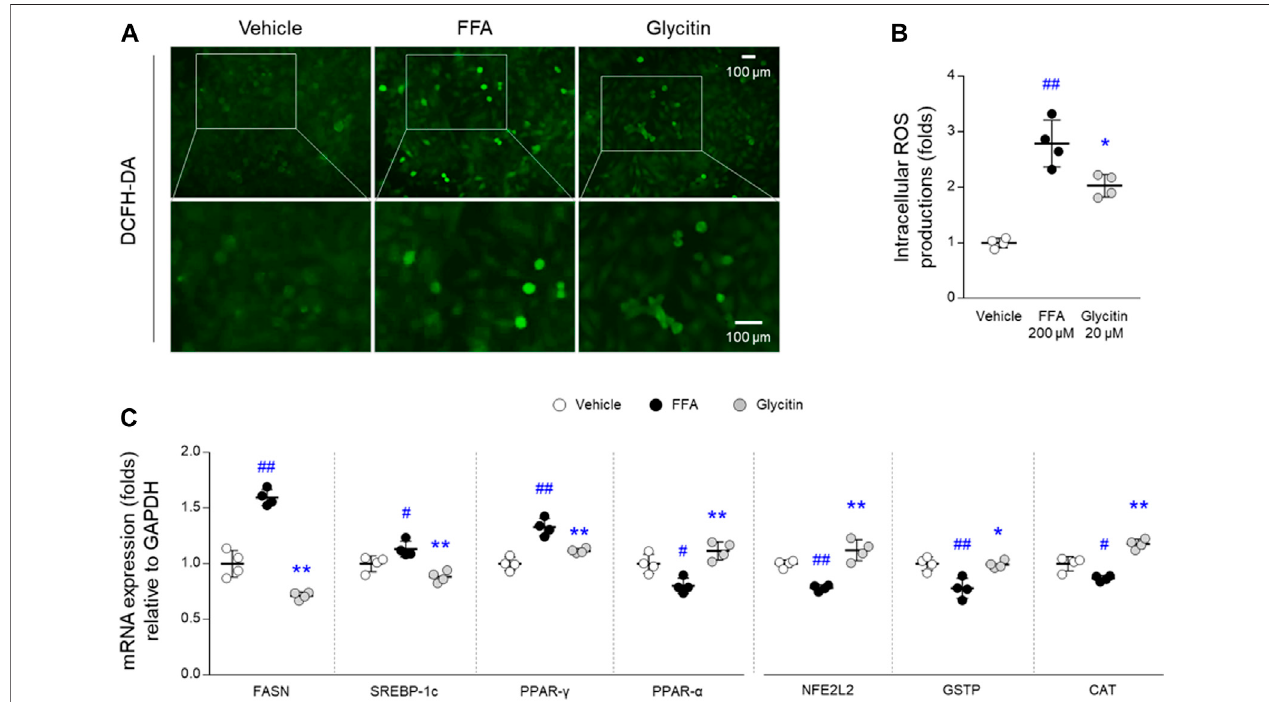
FIGURE 7 | Experimental investigating potential mechanism of glycitin. (A) Intracellular ROS production was determined using DCFH-DA fl uorescence assay, and (B) it was quanti fi ed in HepG2 cells. (C) The mRNA expressions of lipid metabolism- and antioxidant-related genes were measured using quantitative real-time PCR method in HepG2 cells. Data are expressed as the mean ± SD ( n = 4). ## p < 0.05 and ## p < 0.01 compared to the vehicle-treated cells, and p p < 0.05 and pp p < 0.01 compared to the cells exposed to